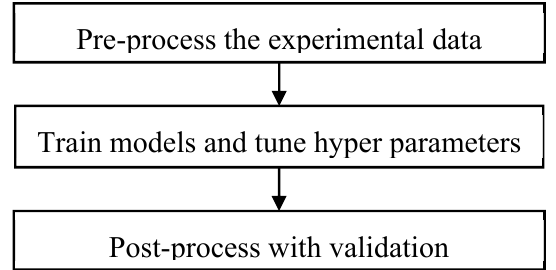
Figure 4. Procedure of models generation.